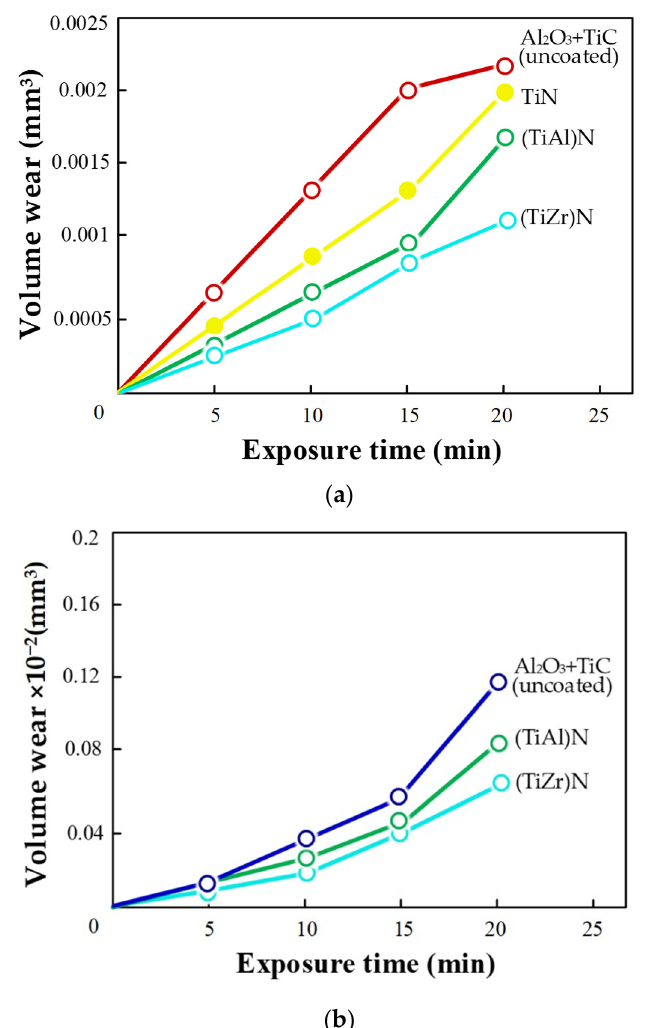
Figure 9. Dependences of volume wear of ceramic inserts made of Al 2 O 3 +TiC with coatings depos- ited on substrates after diamond grinding ( a ) and after diamond grinding, lapping and polishing ( b ) on the abrasive exposure time.